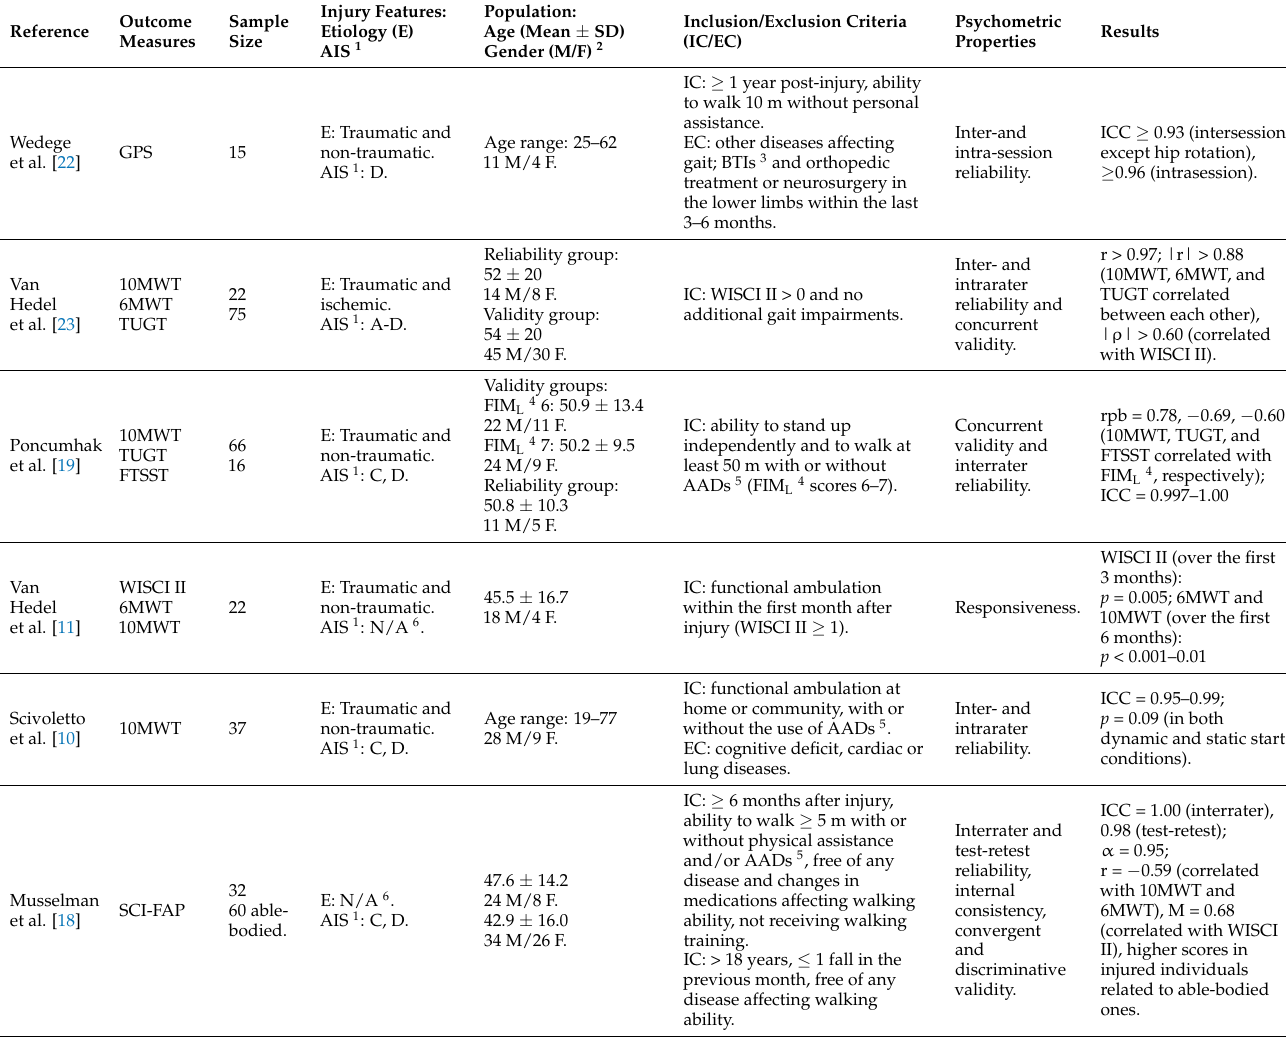
Table 3. Main results of the systematic